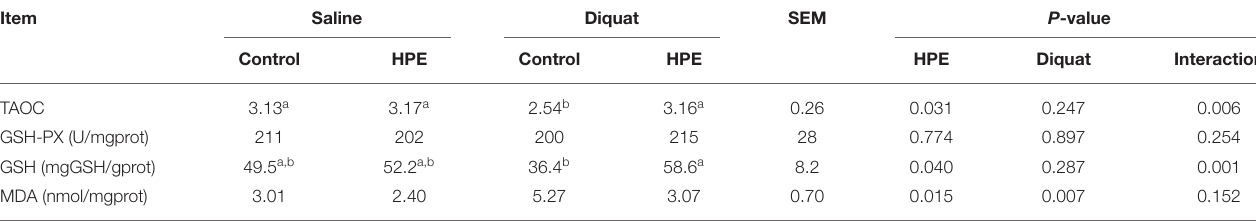
TABLE 4 | The liver antioxidative capacity of the piglets fed holly polyphenols extracts (HPE) diet with diquat challenge. Item Saline Diquat SEM P -value Control HPE Control HPE HPE Diquat Interaction TAOC 3.13 a 3.17 a 2.54 b 3.16 a 211